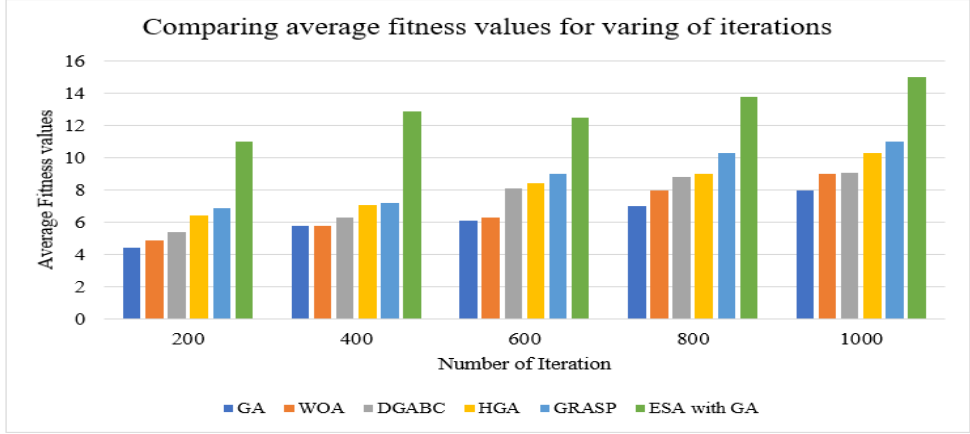
Figure 11. Comparison of the correlation between the numbers of iterations.